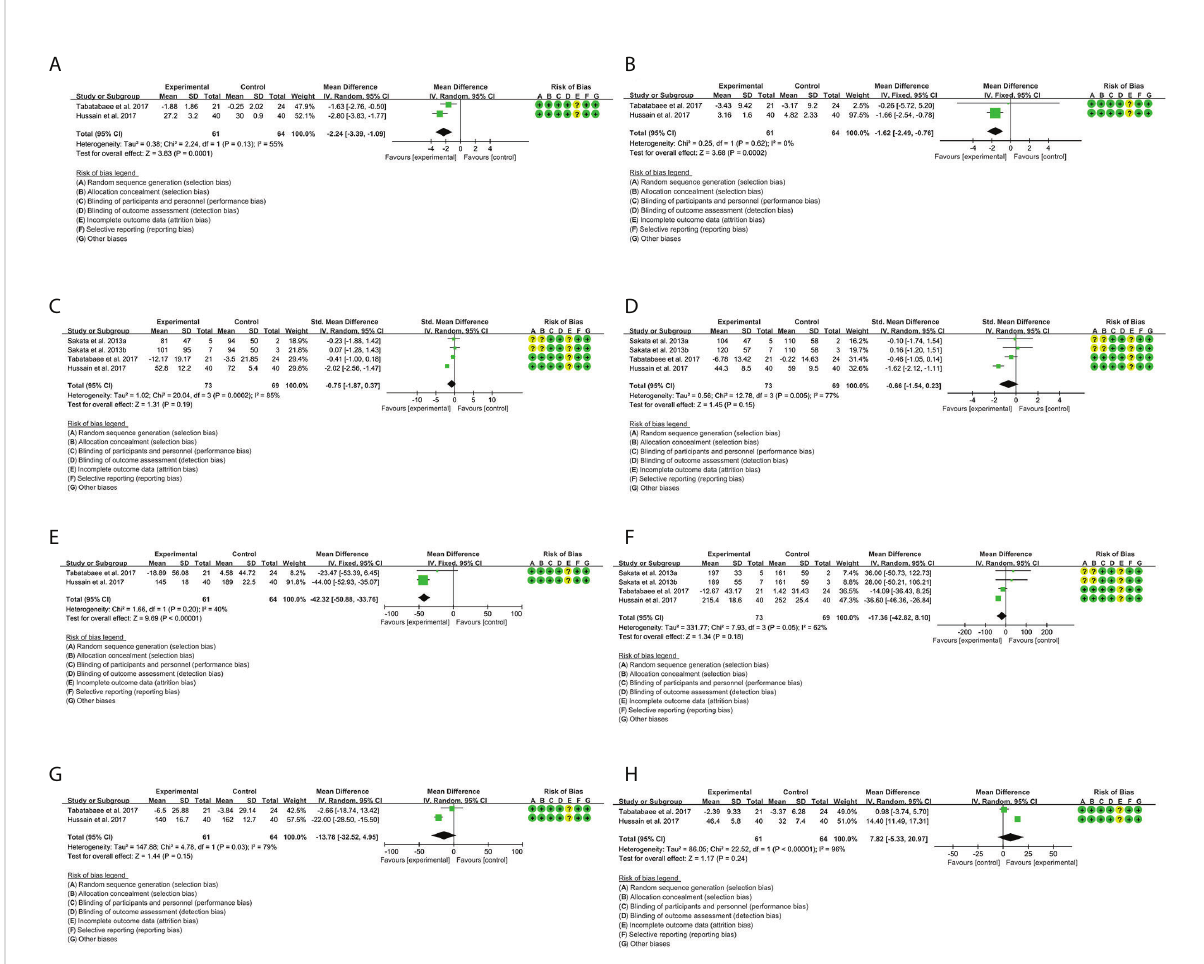
FIGURE 5 Outcomes in catechin treatment ( A : BMI; B : HOMA-IR; C : ALT; D : AST; E : TG; F : TC; G : LDL-C; H :